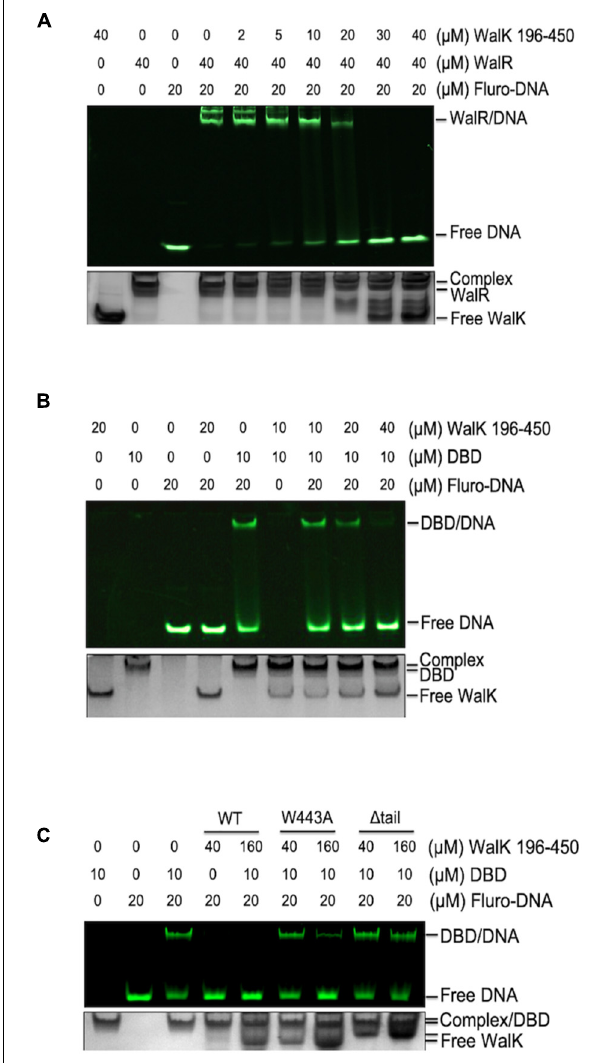
FIGURE 4 | The CTT of S. mutans WalK is important for WalK in competition with promoter DNA. (A,B) WalK (196–450) competes off fluorescein labeled 25-mer promoter DNA from binding to WalR or DBD in a dose-dependent manner. (C) Comparison of the relative ability of CTT mutants (W443A, (cid:49) tail) of WalK to compete with DBD in promoter binding. All samples were mixed and incubated for 15 min at RT before loading onto gels. Final concentrations of proteins and DNA used in the reactions were marked above the panels. All EMSA gels were imaged under UV to show DNA in the upper panel and stained with CBB to visualize protein loading in the lower